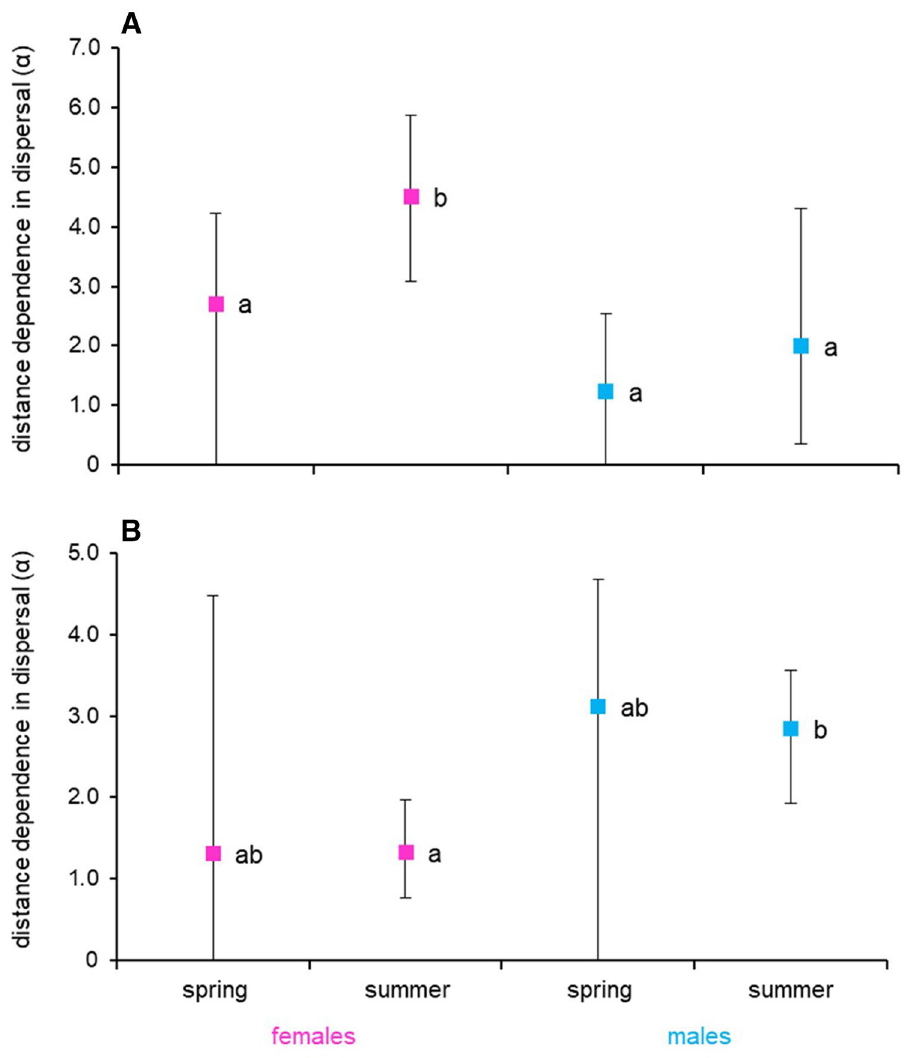
Figure 2. Between-season variation in distance dependence of dispersal in L. helle adults of both sexes in 2018 ( A ) and 2019 ( B ). The estimate values are presented with their 95% confidence intervals; the values statistically different (at P < 0.05) from each other are marked with different alphabet